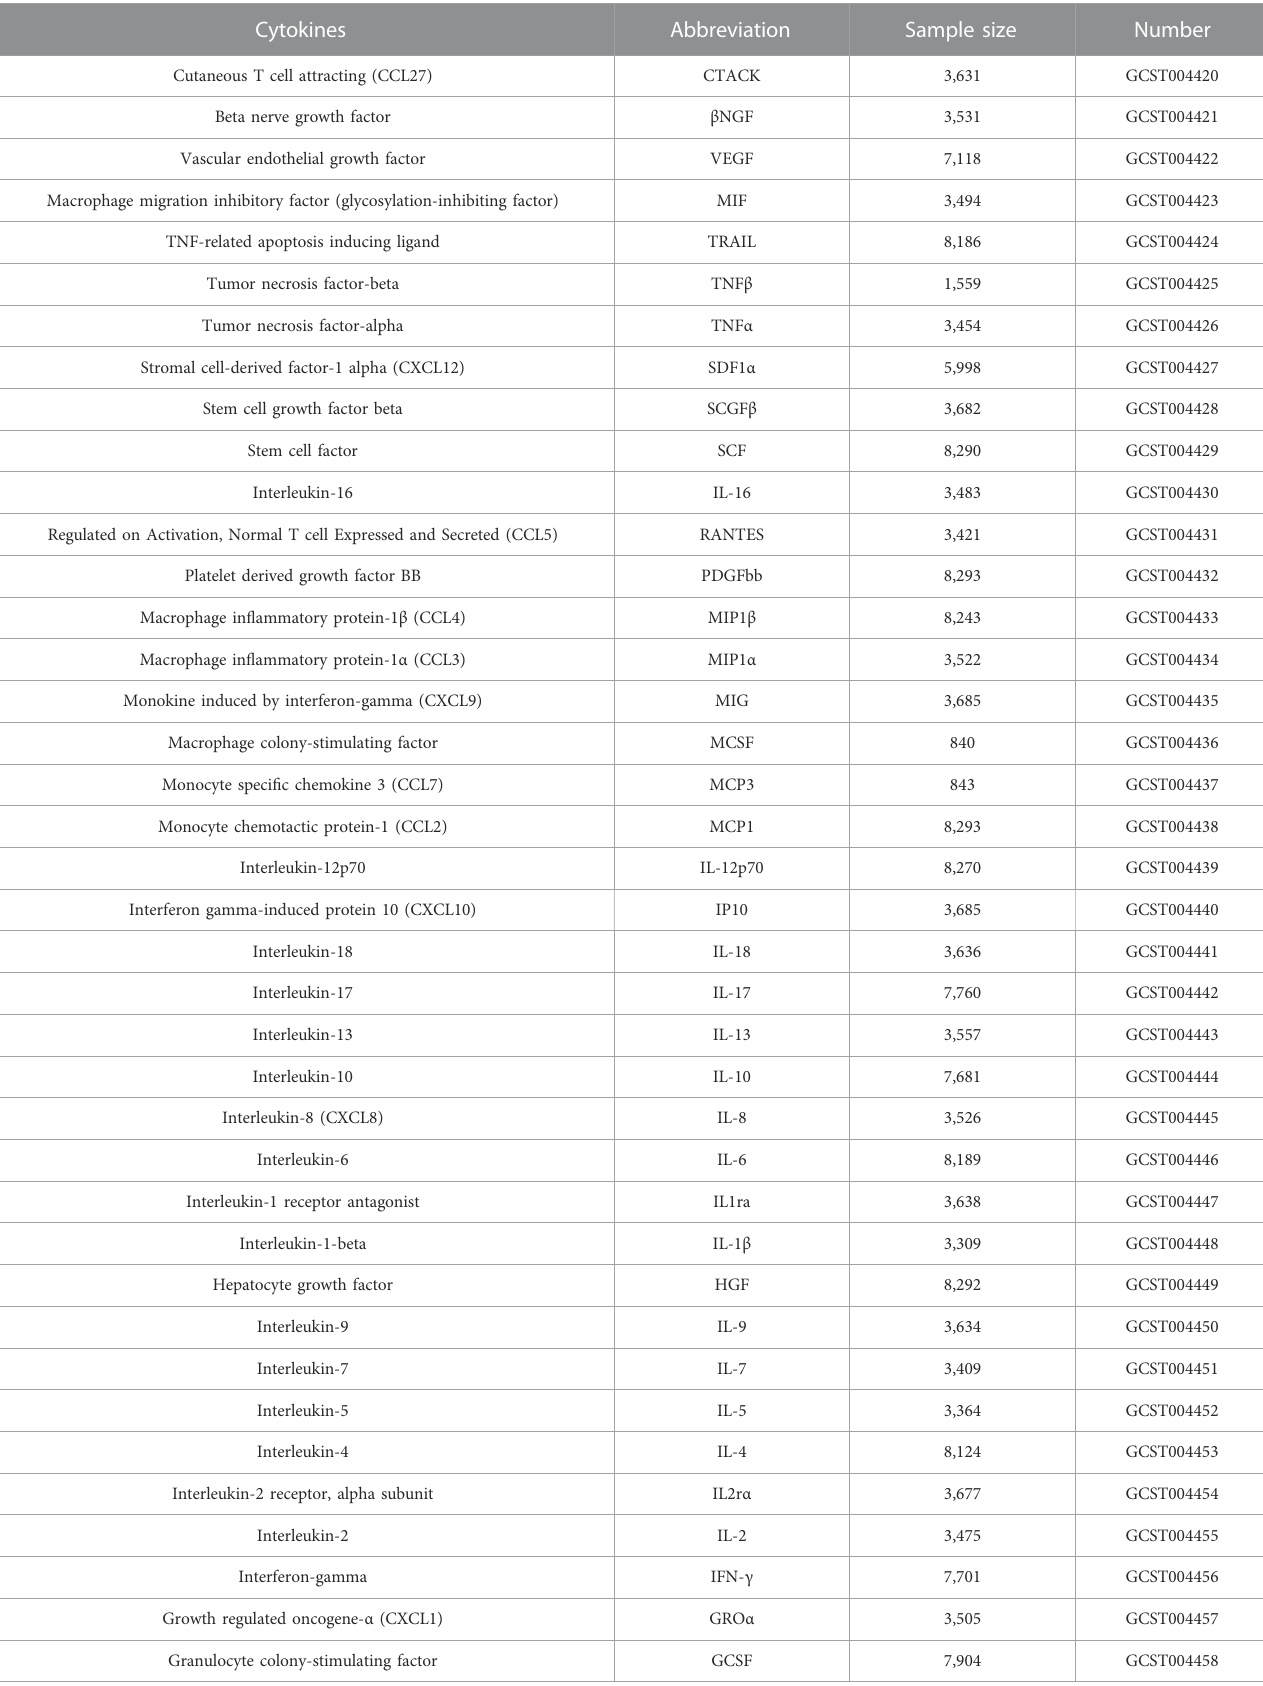
TABLE 1 The sample size for each cytokine analyzed in this study acquired from the